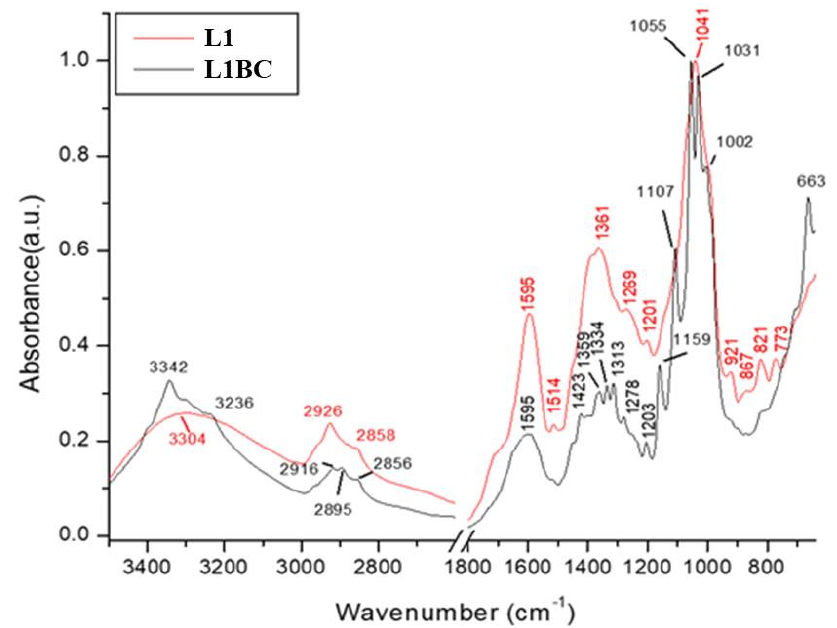
Figure 7. FT-IR spectra of lovage extract (L1) and bacterial cellulose incorporated with lovage extract (L1BC).